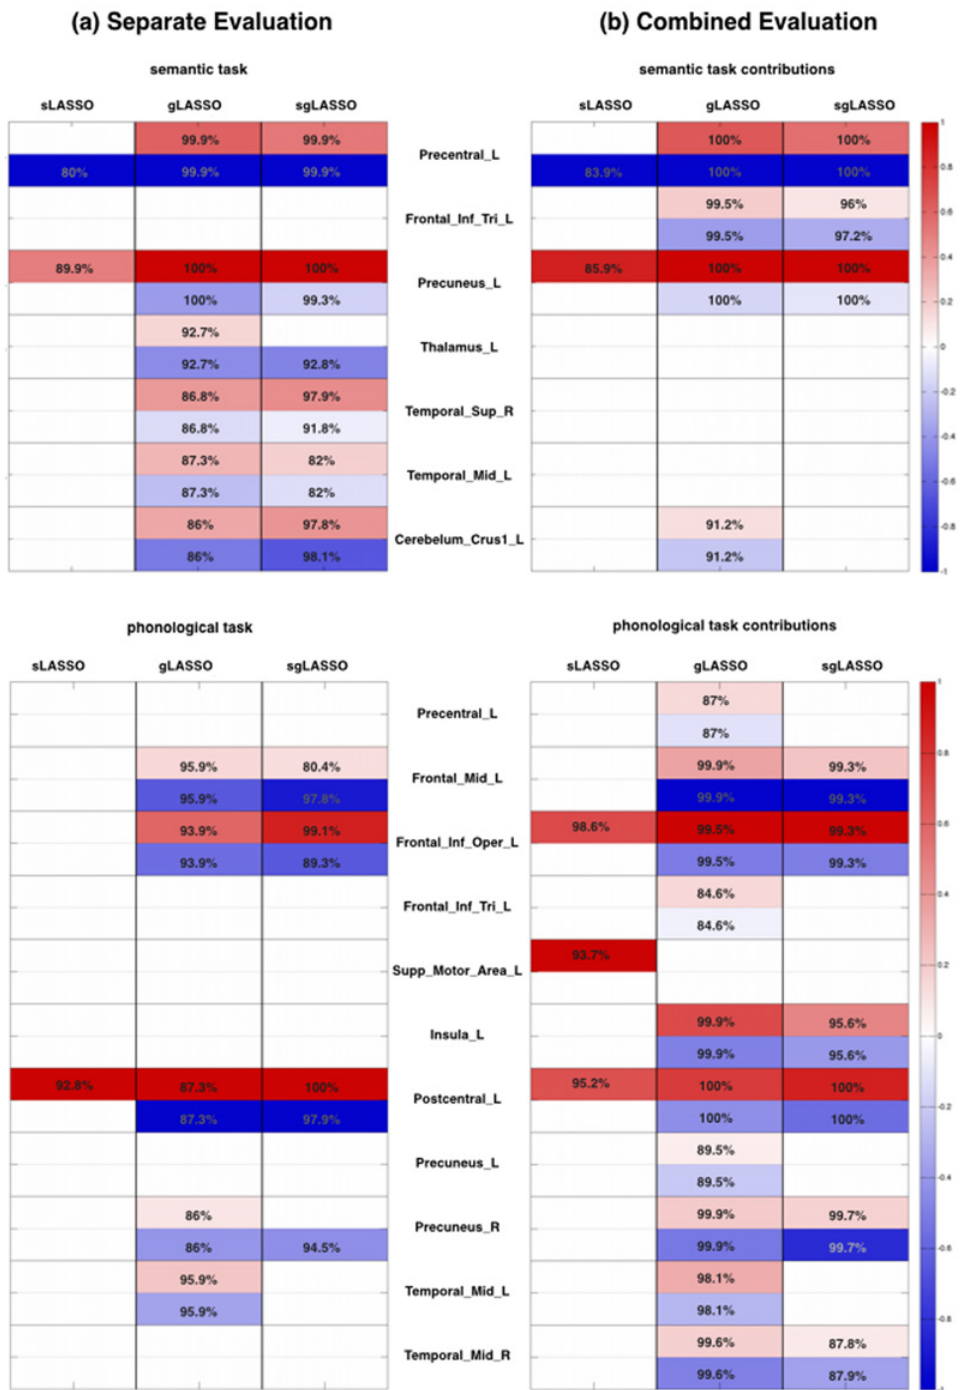
Fig 8. In the combined evaluation, model stability is higher than in the separate evaluation. This is indicated by the selection frequency of the same brain areas during the cross validation. The frequency is generally lower for (a) separate evaluation than in the (b) combined evaluation. Only brain areas selected in more than 80% of all cross validated models are given. Numbers indicate the selection frequency. The colors indicate average values over all positive and negative weights (normalized by the highest average positive and negative value over all brain areas, resp.). Areas more highly activated in control subjects than in depressed subjects are in blue; areas more highly activated in depressed subjects than in control subjects are in red. For gLASSO, the sum of negatively and positively weighted voxels cover 100% of the brain area of interest, so that the selection frequency is the same.